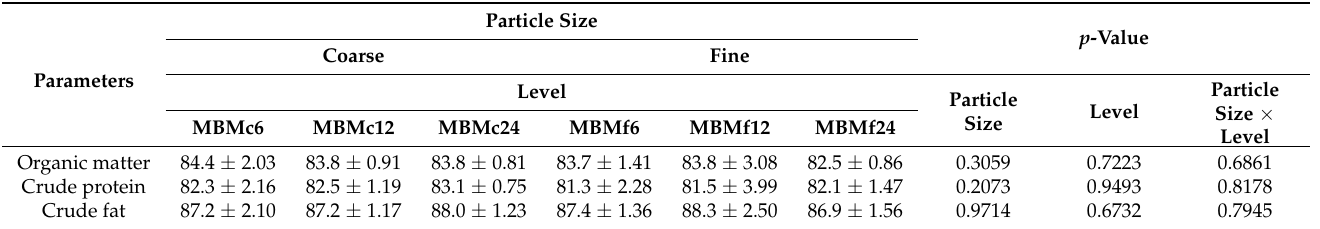
Table 2. Apparent nutrient digestibility (%) of dogs fed basic diets supplemented with different levels and particle sizes of MBM (mean ±